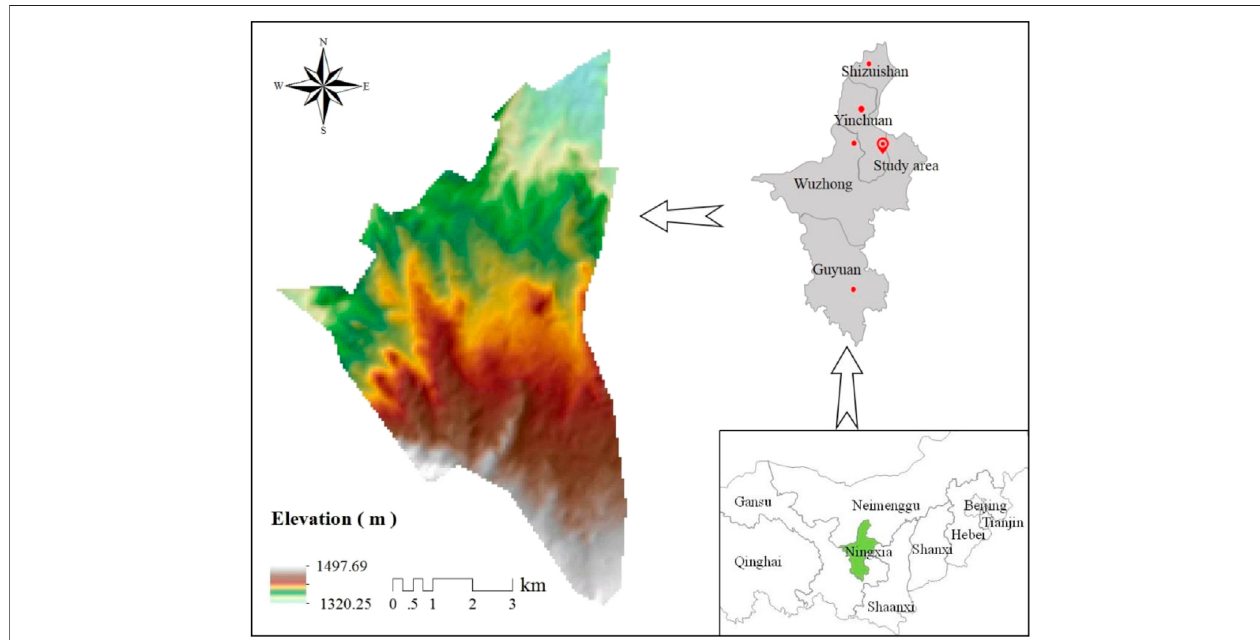
FIGURE 1 | Study area